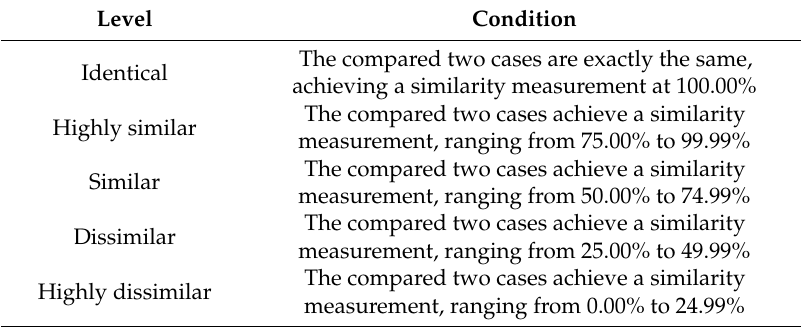
Table 4. Correspondence between similarity level and